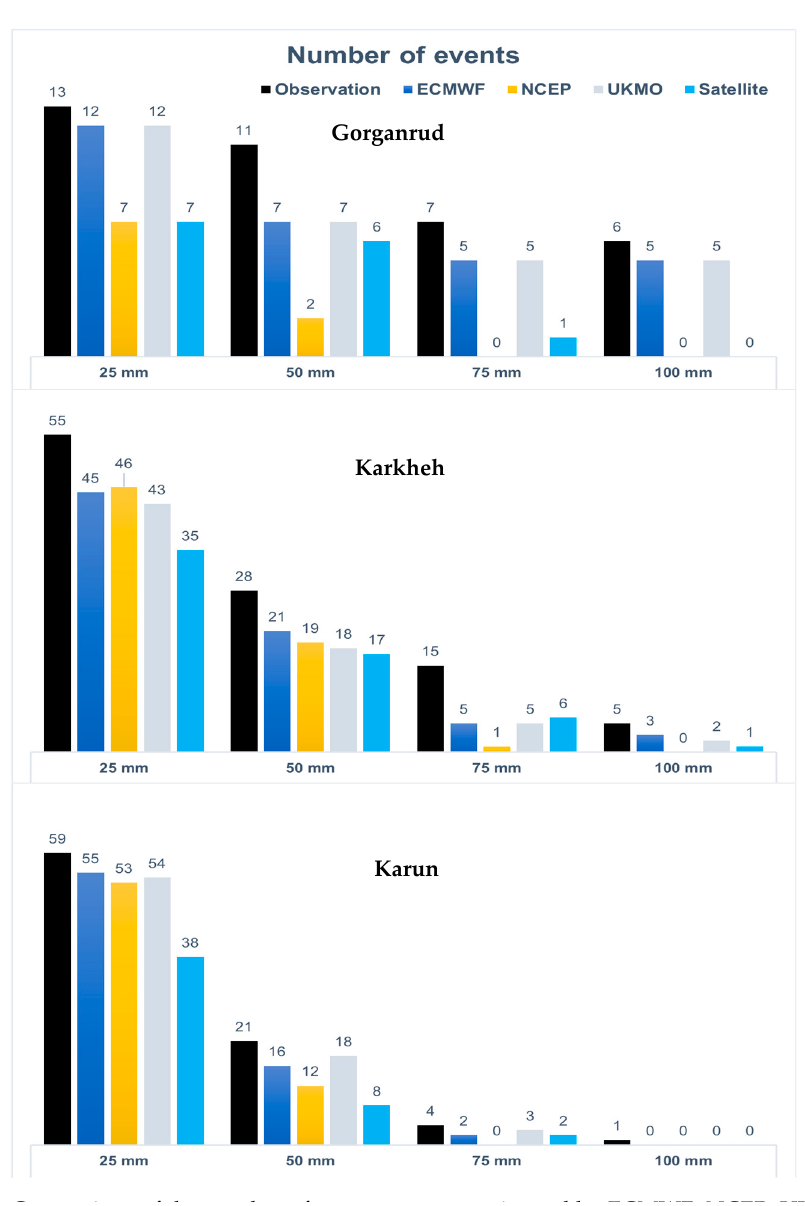
Figure 10. Comparison of the number of extreme events estimated by ECMWF, NCEP, UKMO, and IMERG with in situ observations.